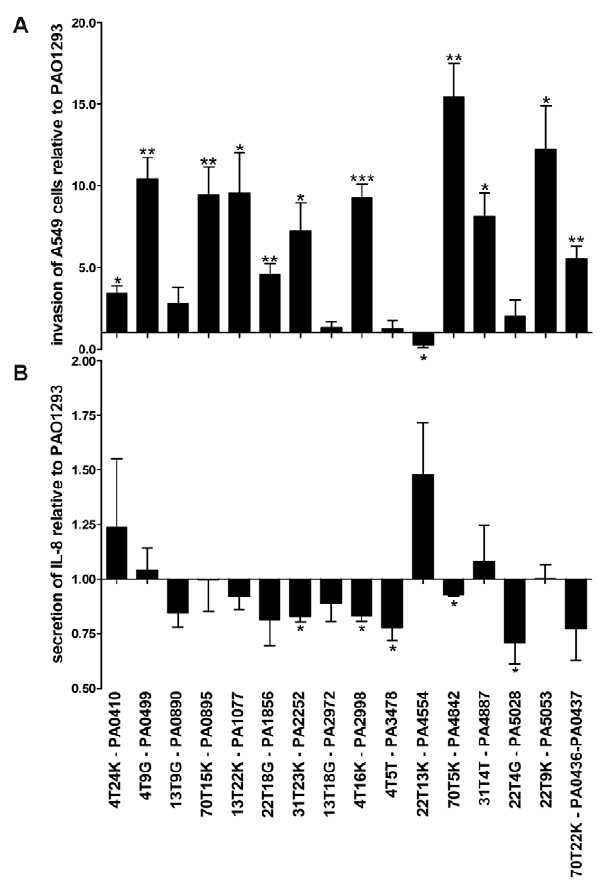
Figure 4. Stimulation of A549 with P. aeruginosa Pos-STM mutants. A ) Fold of invasion relative to PAO1293 after 2 h of stimulation with Pos-STM mutants. B ) IL-8 secretion was quantified by ELISA after stimulation with Pos-STM mutants for 2 h. Measurements were performed in triplicate. *p , 0.05, **p , 0.01, ***p , 0.001 in the Student’s